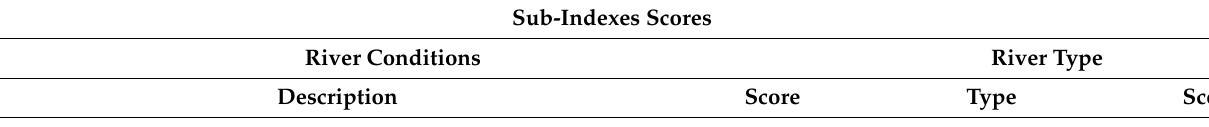
Table 11. Scores of sub-indexes in hydrology and climate index.